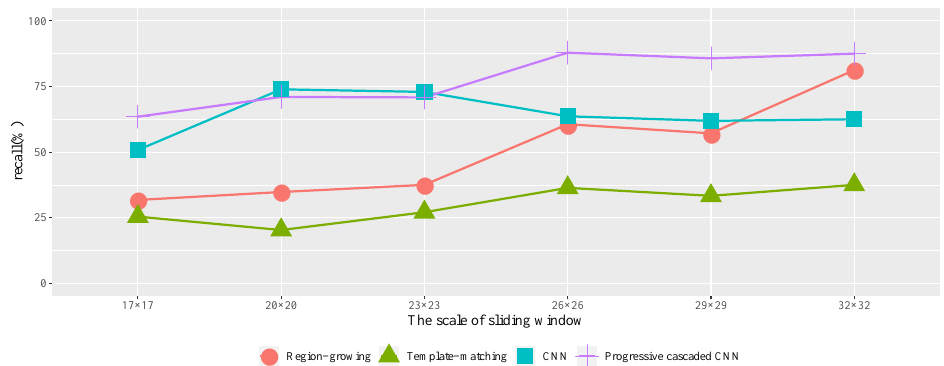
Figure 16. Comparison of detection precision for different methods.